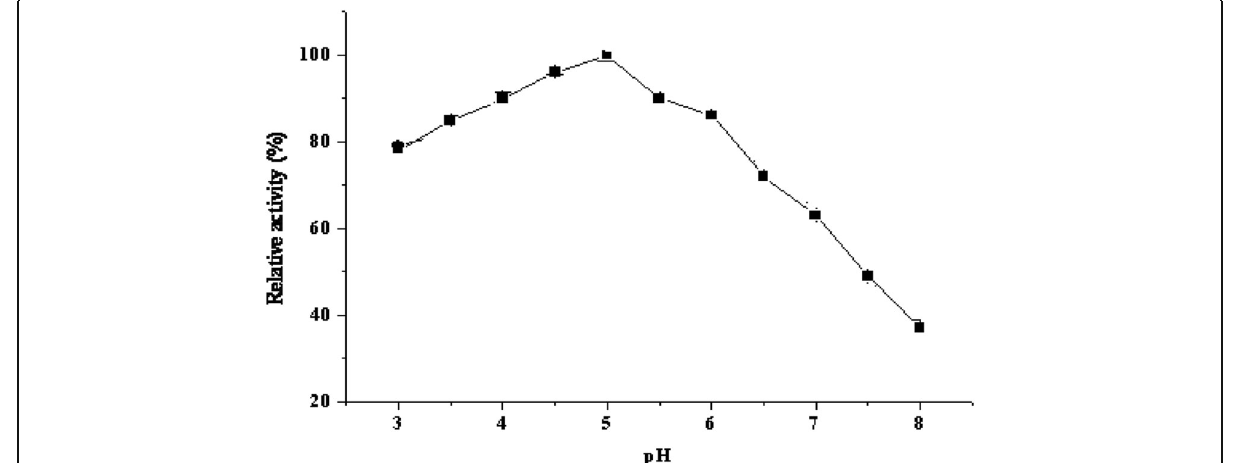
Fig. 3 Effect of pH on alpha-galactosidase activity in Penicillium